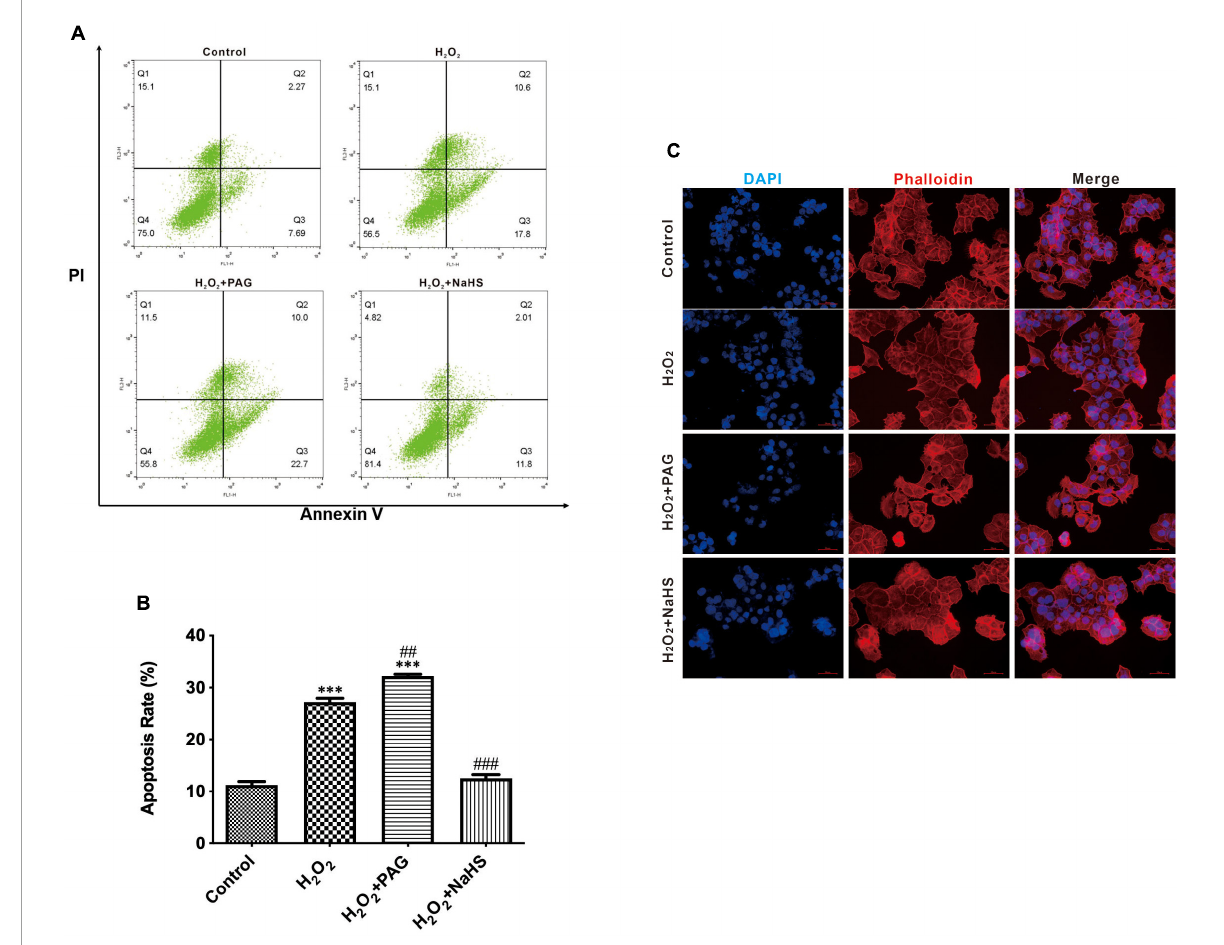
FIGURE2 H 2 O 2 induced HTR-8/SVneo cells apoptosis. The proportion of apoptotic cells was detected by Annexin V. (A) Representative pictures of Annexin IV and PI-derived fluorescence in HTR-8/SVneo cells after different treatments. (B) Summarize the flow cytometry results. (C) Different groups of cells had different morphology changes in the cell nucleus (400 × ). The data are expressed as mean ± SEM. ∗∗∗ Vs. Control, P < 0.001. ## Vs.